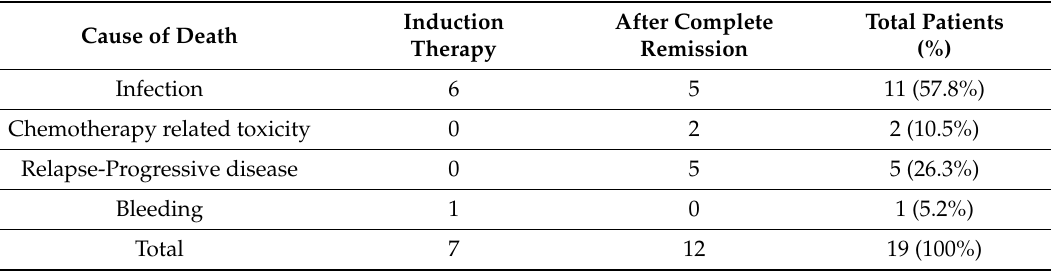
Table 4. Causes of death.